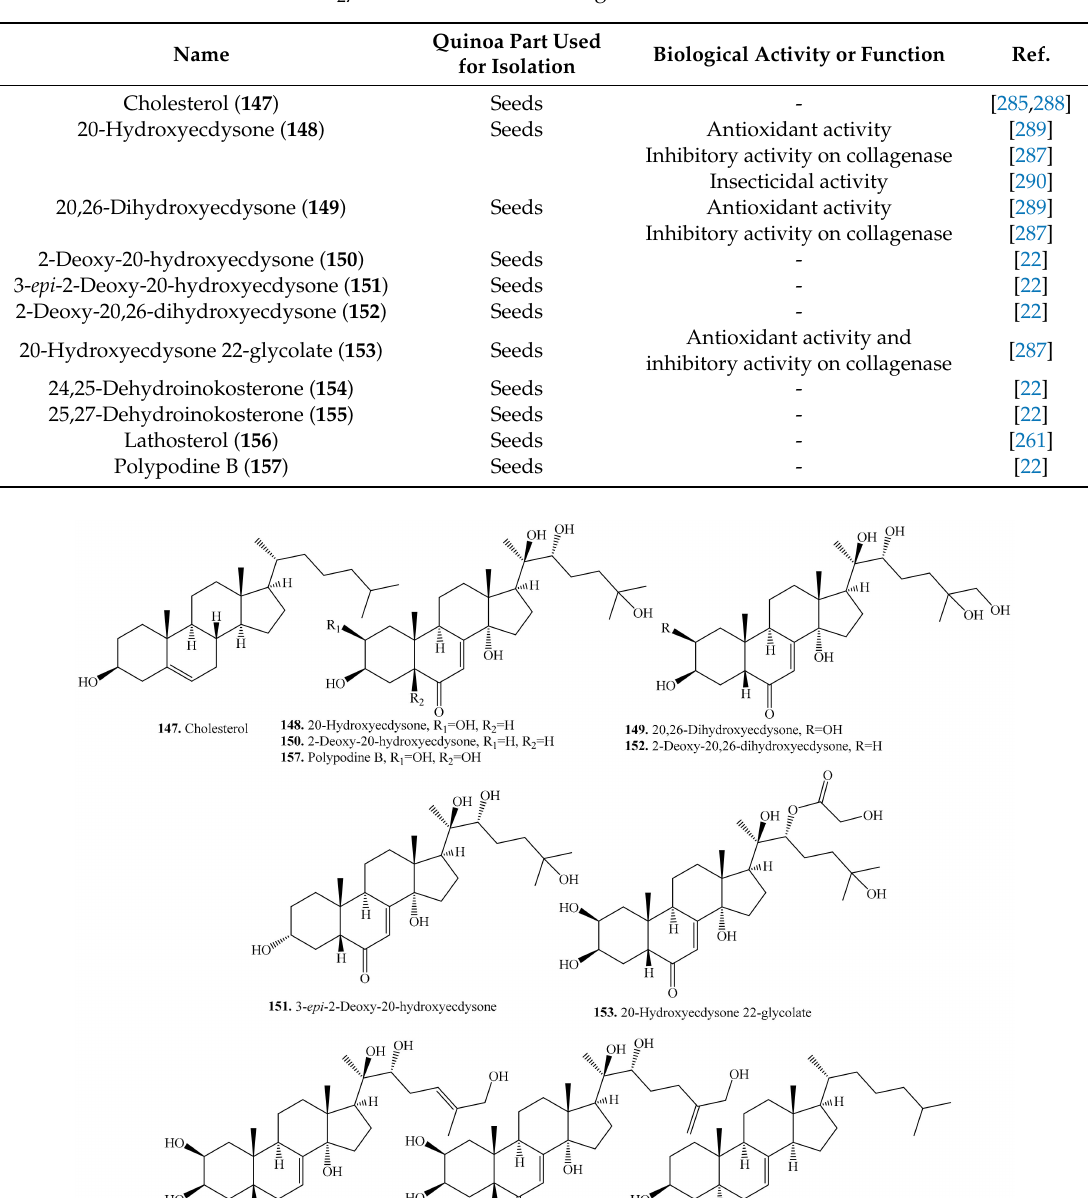
Table 19. C 27 -Steroids and their biological activities or functions.